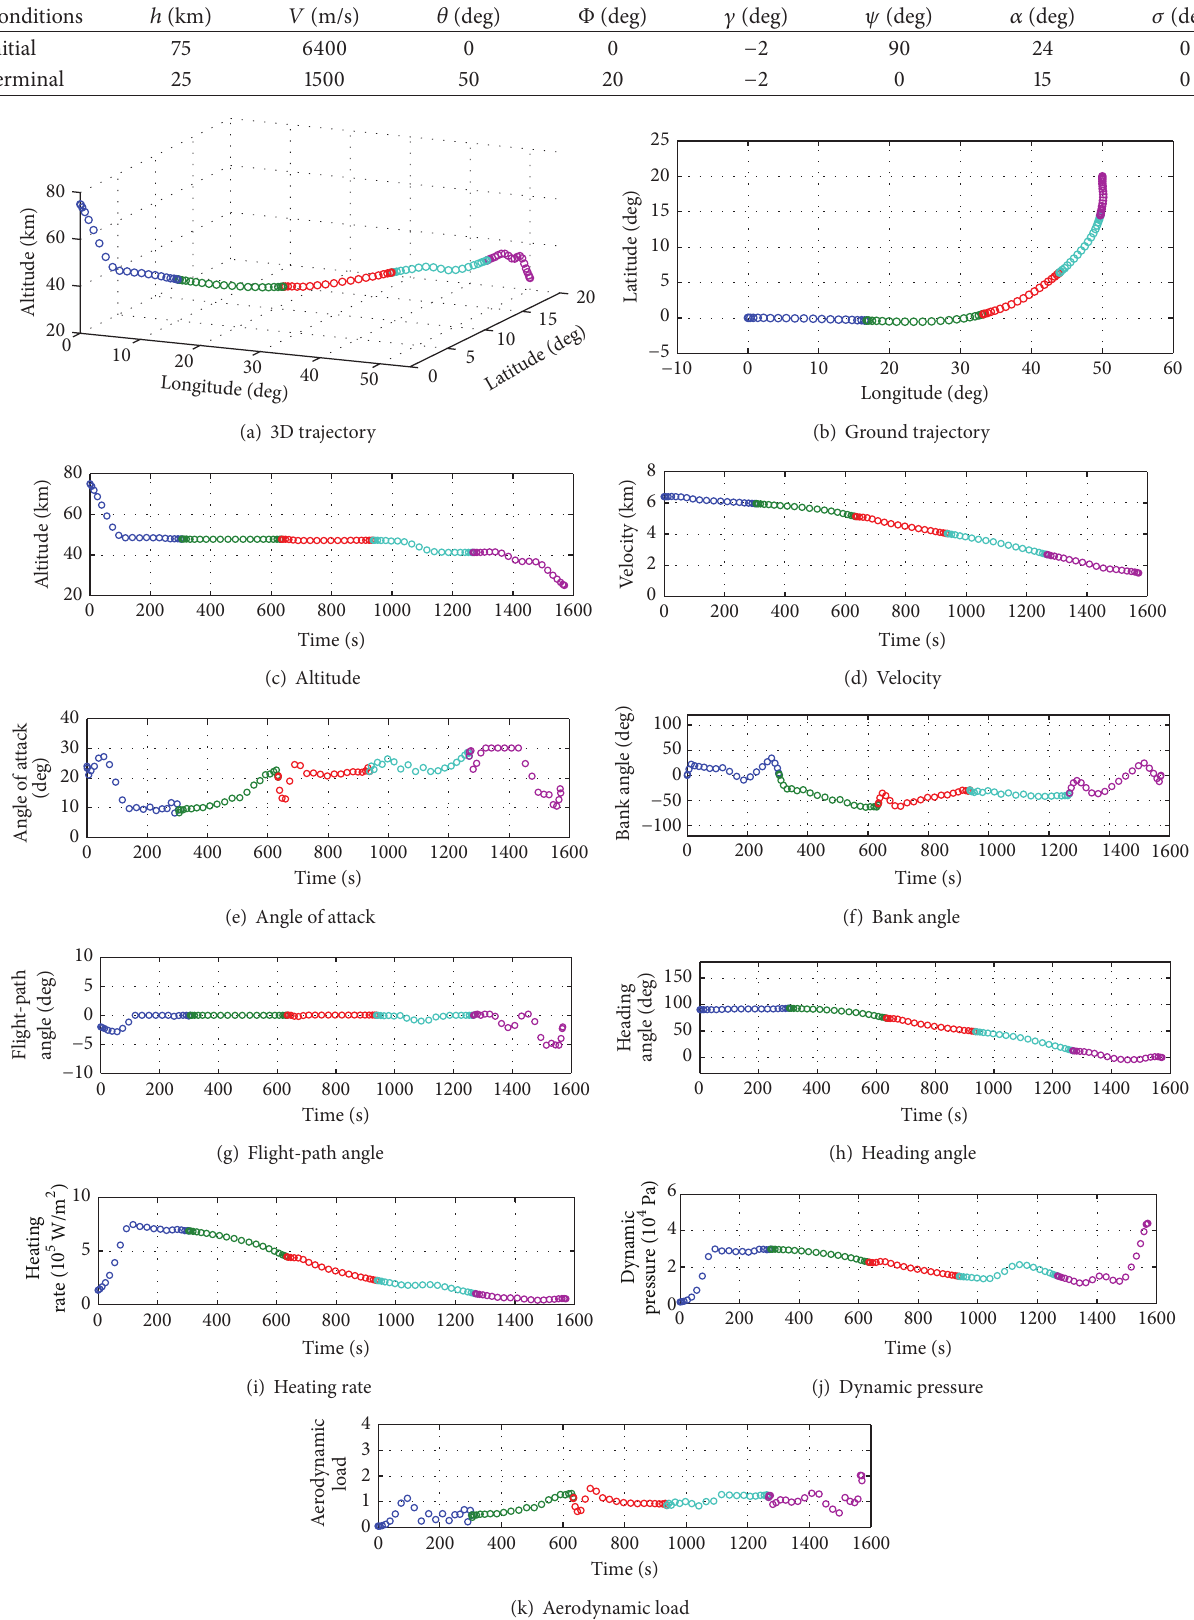
Table 3: Initial and terminal conditions of full trajectory (Case 1).